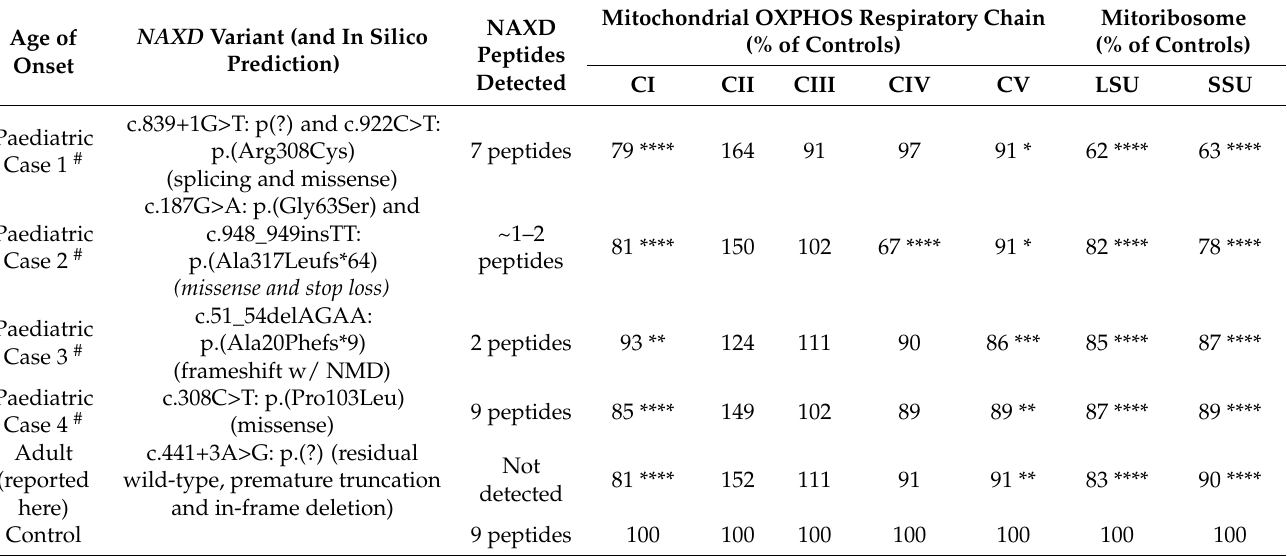
Table 1. Summary of quantitative proteomic analysis in fibroblasts from adult-onset and paediatric NAXD